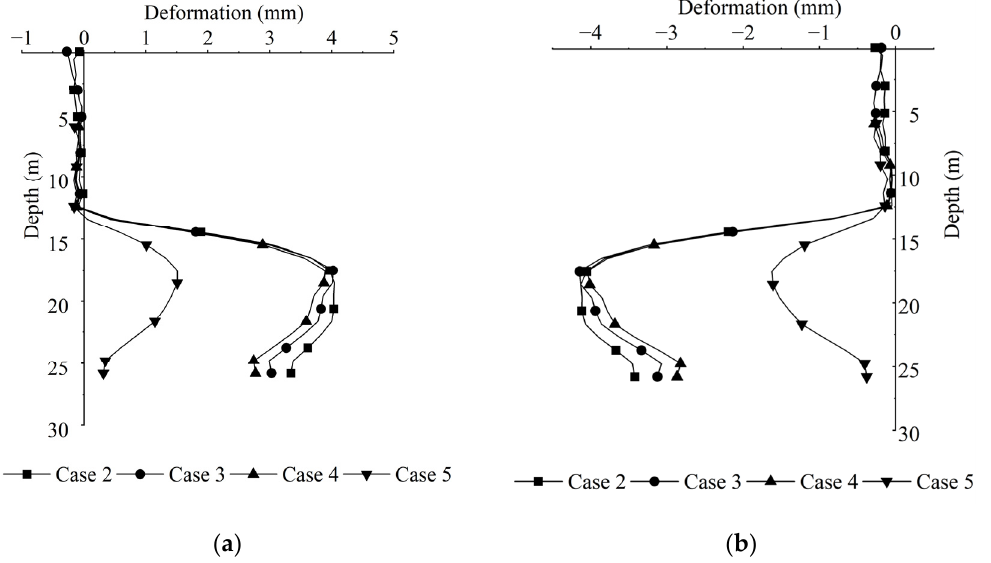
Figure 12. Lateral deformation of supporting pile subjected to symmetric construction: ( a ) southern pile and ( b ) northern pile (unit: mm).